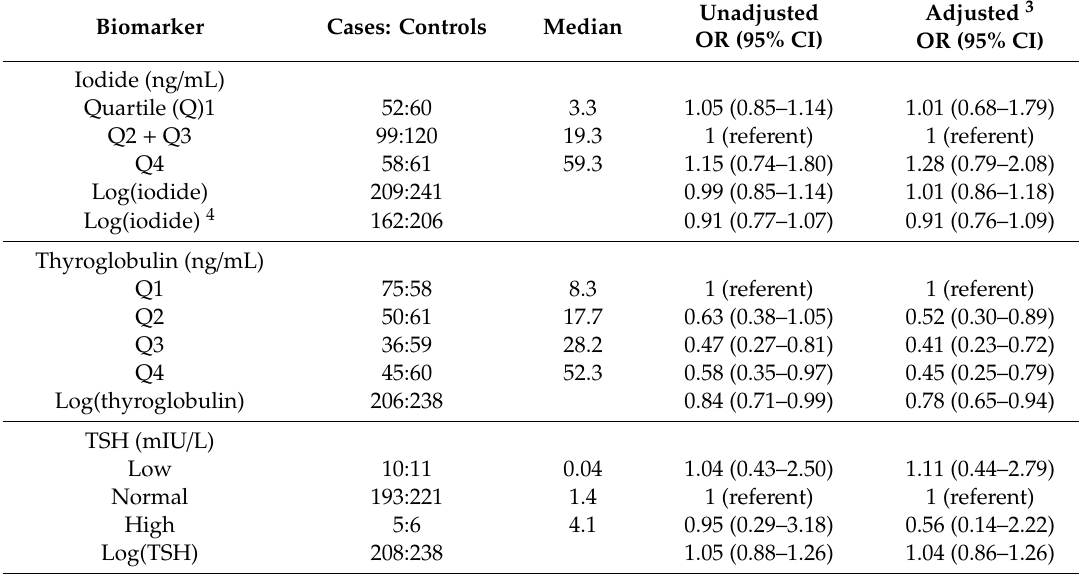
Table 3. Unadjusted and adjusted odds ratios (ORs) and 95% confidence intervals (CIs) for small for gestational age according to maternal serum iodide, thyroglobulin, and thyroid stimulating hormone in the Finnish Maternity Cohort and Maternal Birth Register, 2012–2013 1,2